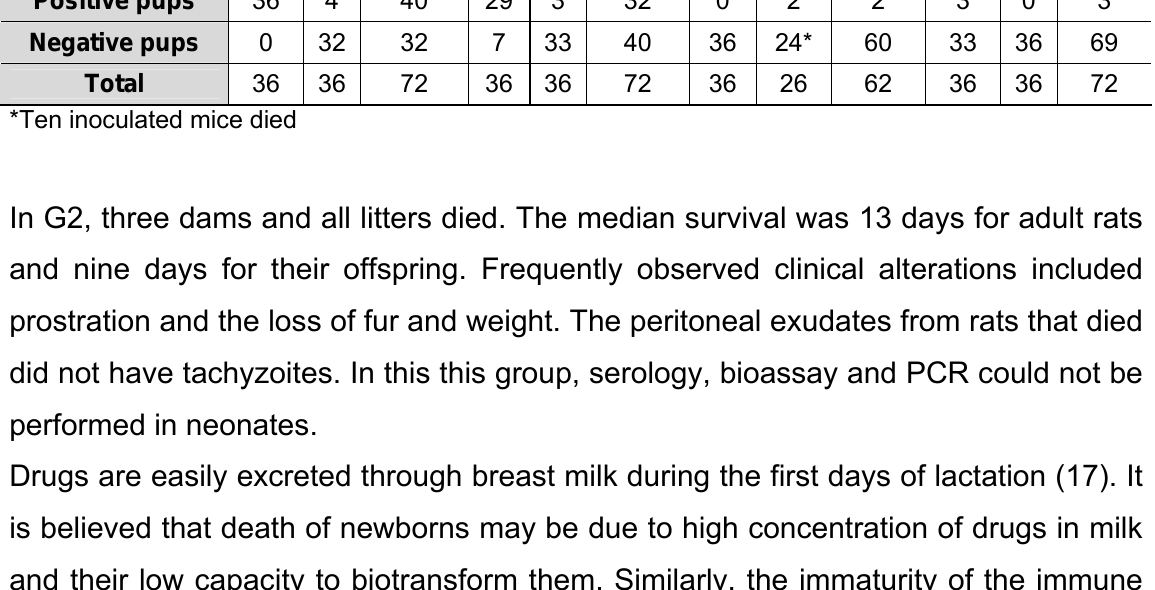
Table 1. Distribution of positive and negative pups according to the diagnostic technique and experimental group Serological MAT Serological IFAT Bioassay PCR Group Group Group Group G1 G3 Total G1 G3 Total G1 G3 Total G1 G3 Total Positive pups 36 4 40 29 32 Negative pups 0 32 32 Total *Ten inoculated mice